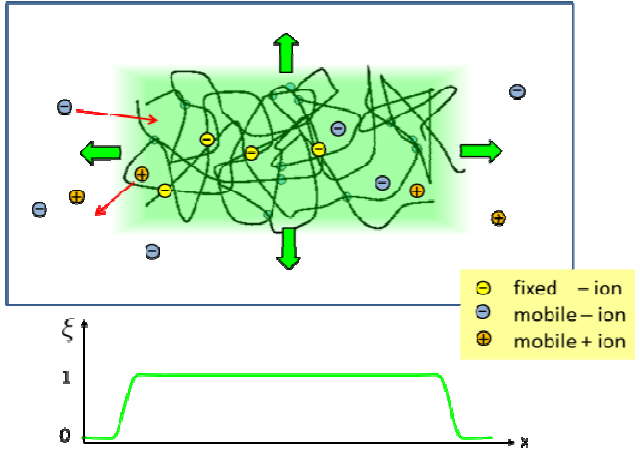
Figure 1. Sketch of a hydrogel attached to the network, and mobile cations and anions. In the phase field method, all system components are represented by continuous field variables. The extension of the hydrogel is characterized by a phase field variable region (light green area). At the interface to the bath, the phase field decreases smoothly to